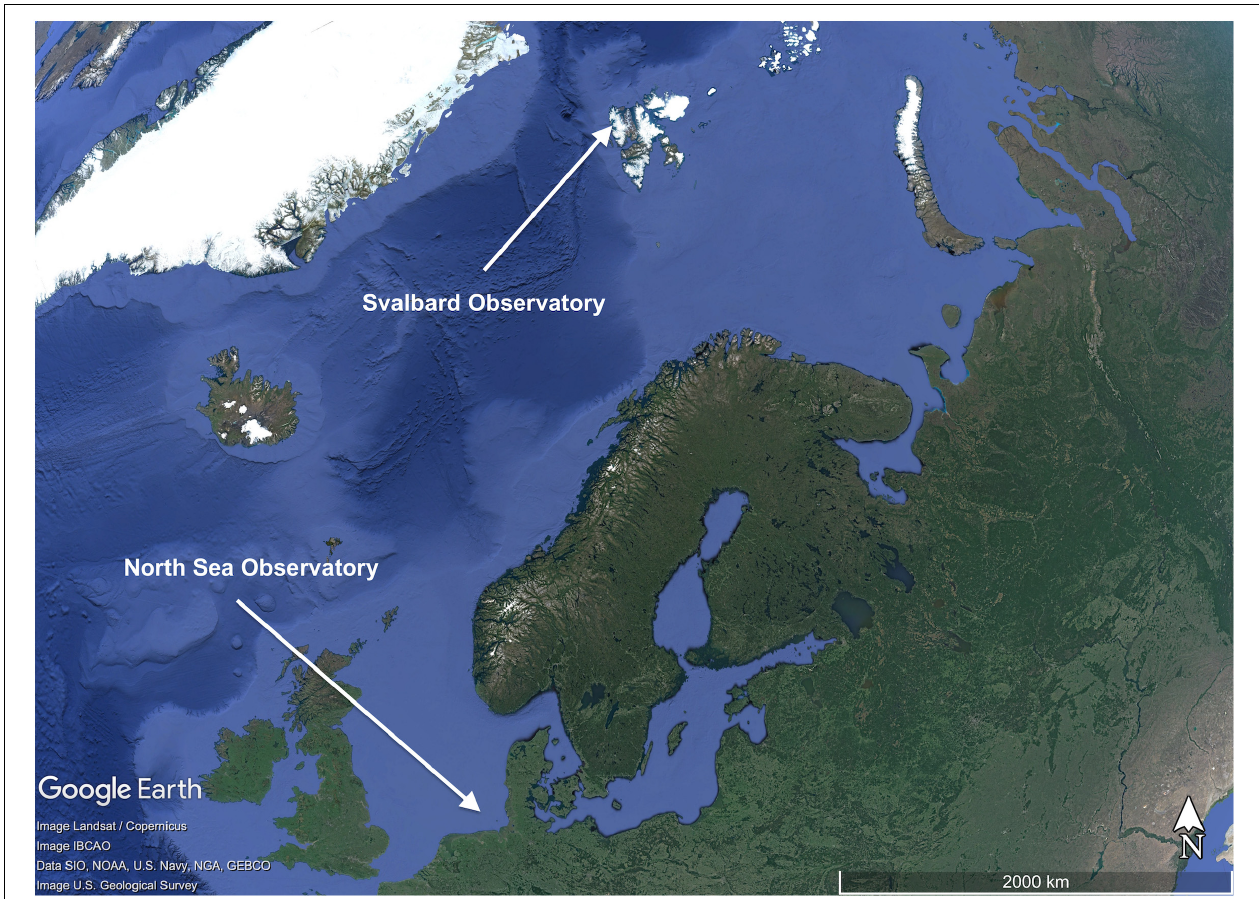
FIGURE 1 | Location of the two COSYNA observatories in the southern North Sea (COSYNA-Helgoland) and the Arctic Ocean in the Svalbard archipelago